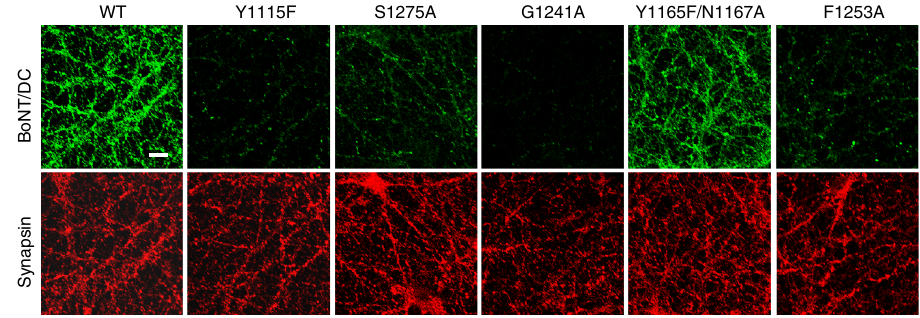
Fig. 6 Mutations at the GBS or at the extended loop reduced binding of BoNT/DC-H C to neurons. Experiments were carried out as described in Fig. 1d, with WT or the indicated mutants of BoNT/DC-H C . Mutations at the GBS (Y1115F, S1275A, and G1241A) and a mutation at the extended loop (F1253A) all reduced binding of BoNT/DC-H C to neurons. Y1165F/N1167A did not affect binding BoNT/DC-H C to neurons. One of two independent experiments is shown